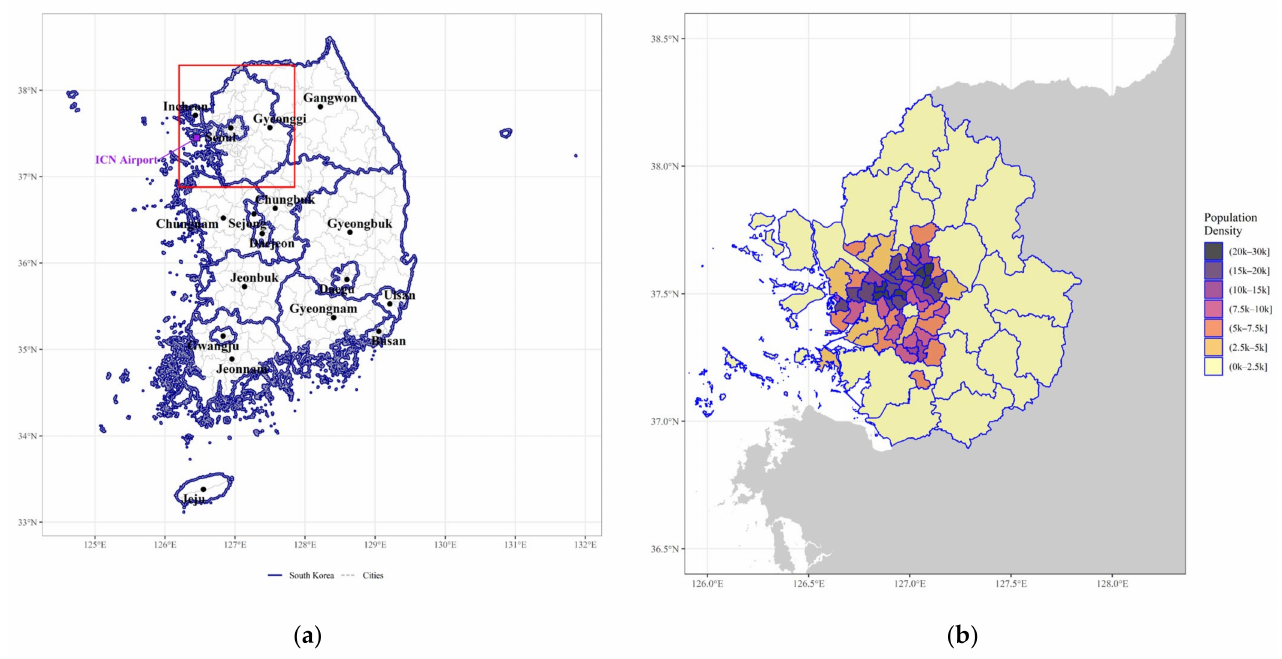
Figure 2. ( a ) Map of South Korea; ( b ) Population density of the Seoul capital